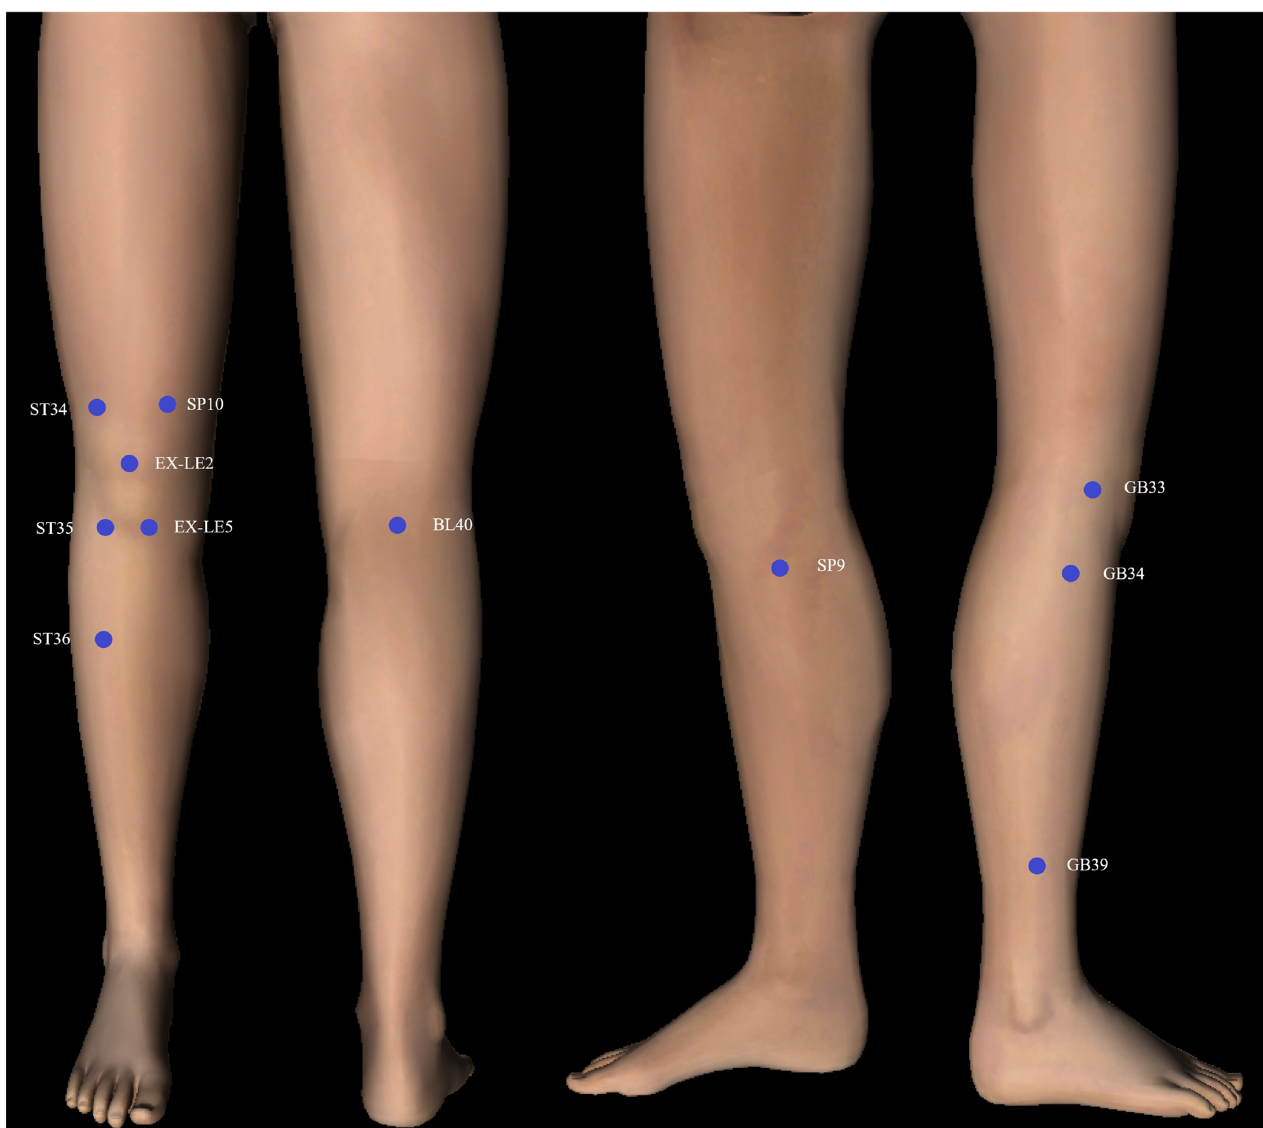
Fig 3. The location of the region of interest. The blue dots are centered on the acupoint positioning.